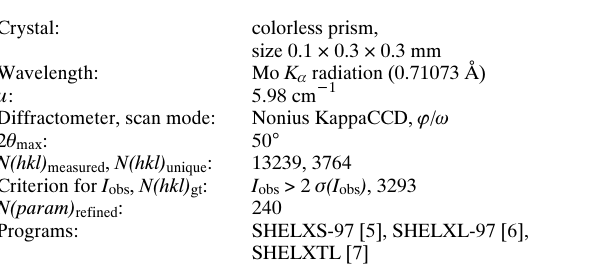
Table 1. Data collection and